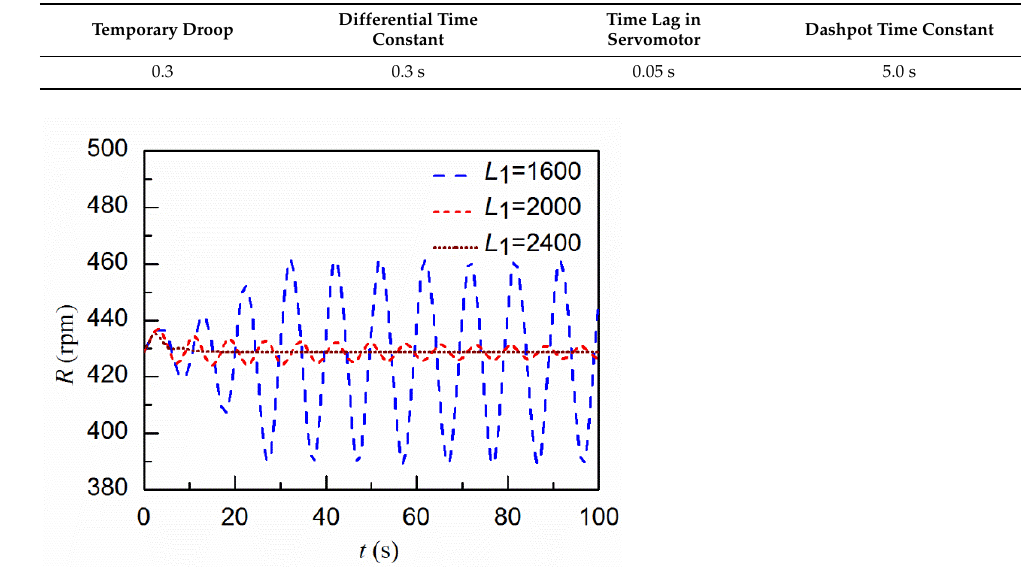
Figure 14. Comparison of the turbine rotational speed with different locations of the sand basin ( h = 10 m, w = 10 m).